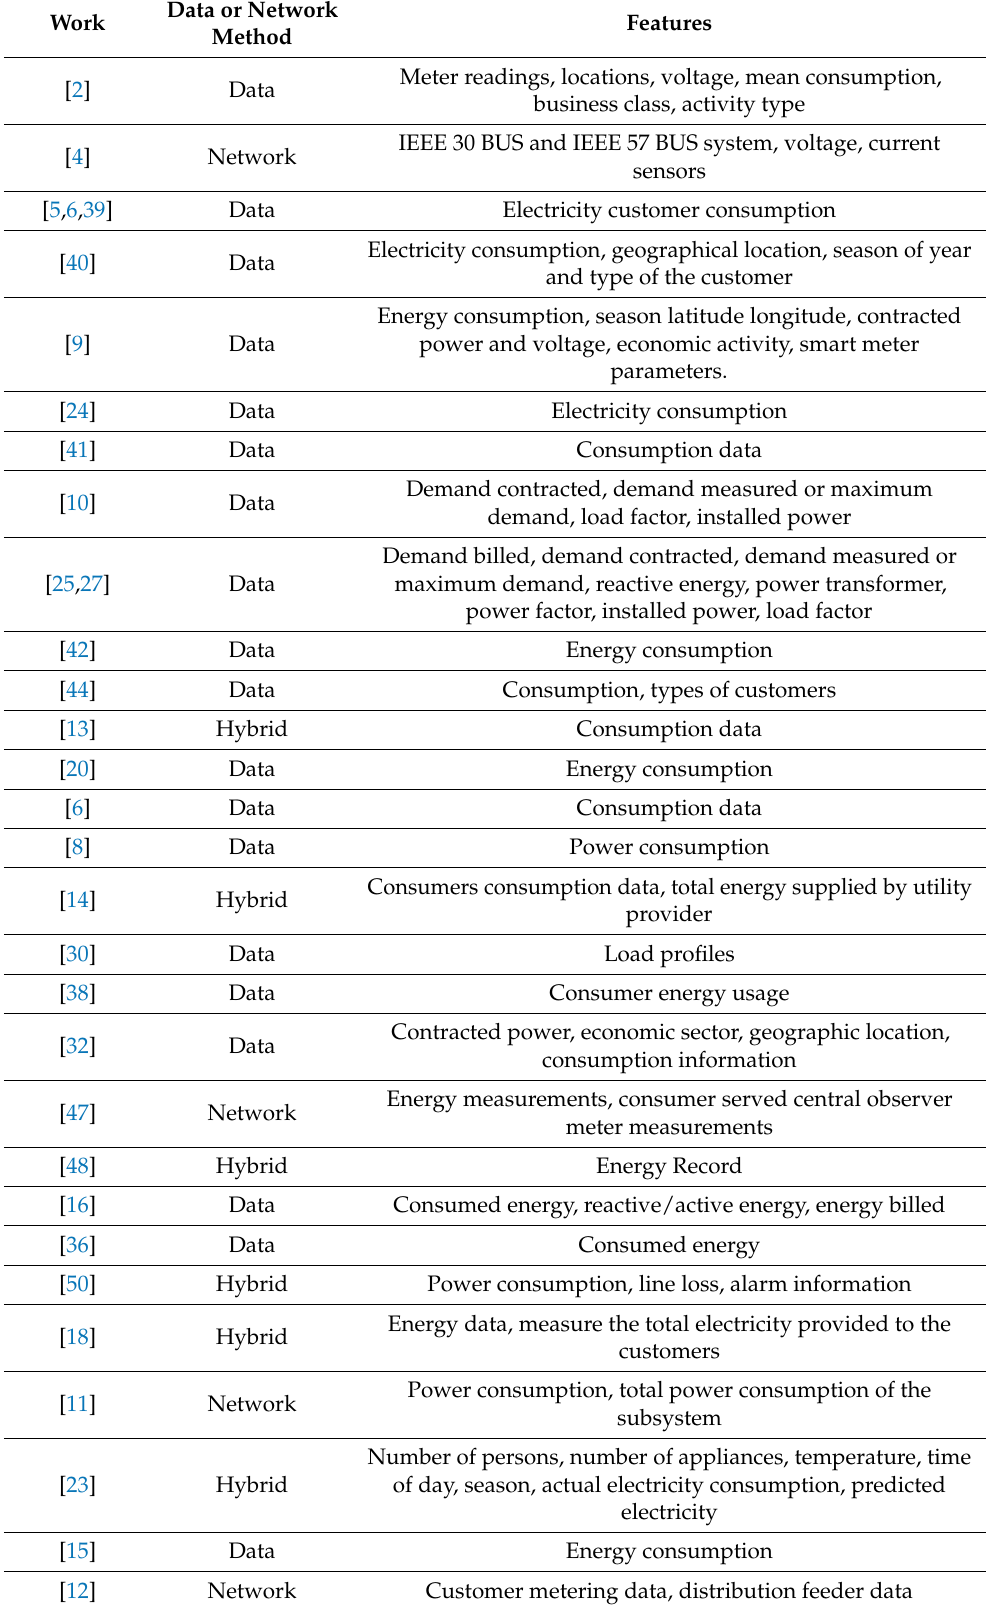
Table 5. Features of non-hardware-based NTL detection